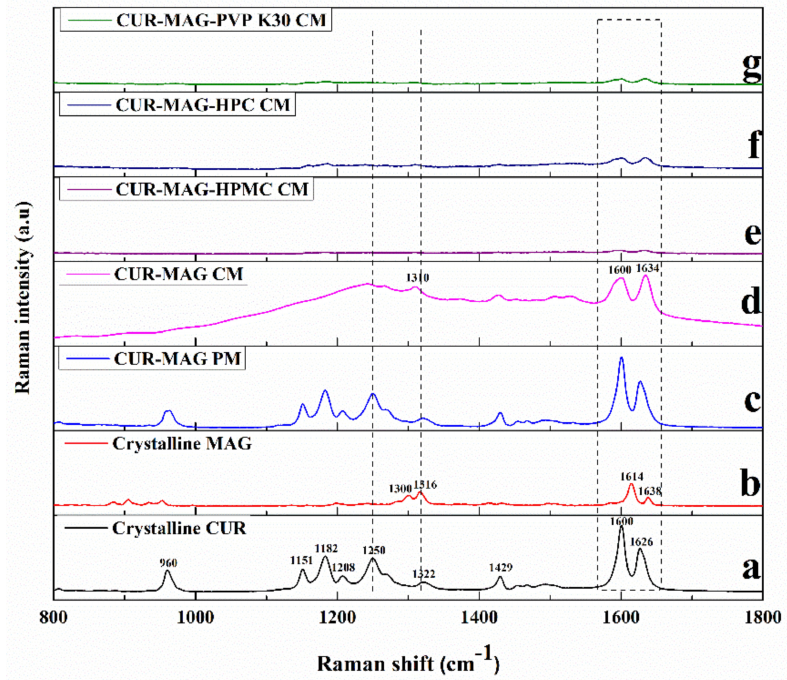
Raman spectroscopy: ( a ) crystalline CUR; ( b ) crystalline MAG; ( c ) CUR-MAG PM; ( d ) CUR-MAG CM; ( e ) CUR-MAG-HPMC CM; ( f ) CUR-MAG-HPC CM; ( g ) CUR-MAG-PVP K30